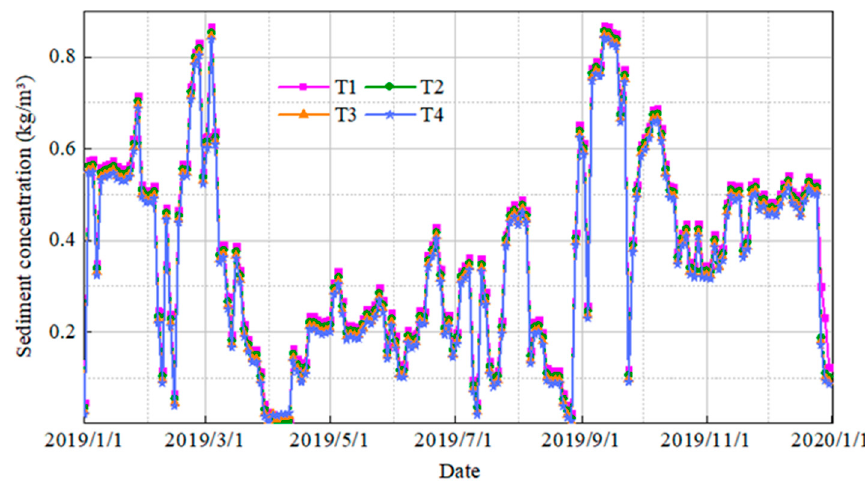
Figure 6. Variation regularity of sediment concentration at characteristic points.